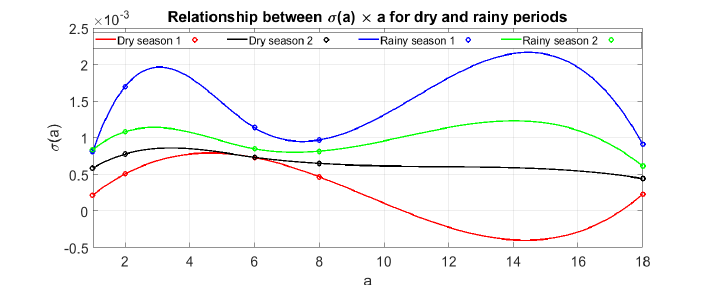
Figure 10. Directions and spacing used for the Wenner arrangement.